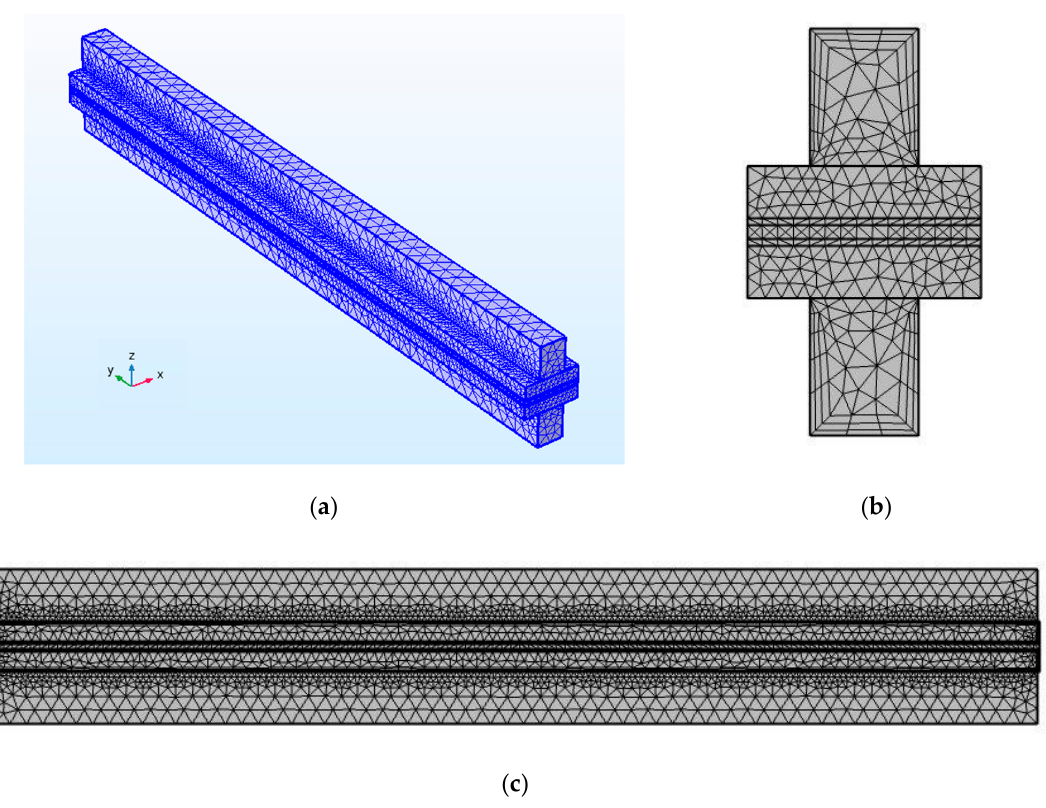
Figure 2. Multi-grid mesh for HT-PEMFC ( a ) isometric view, ( b ) right view, ( c ) front view.